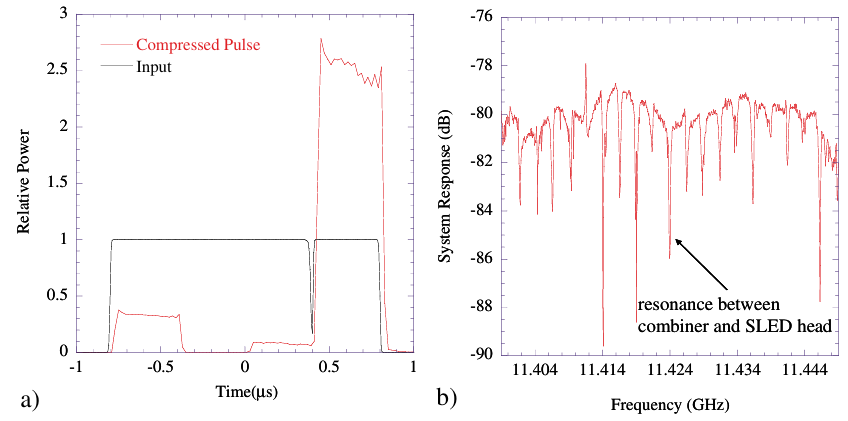
FIG. 20. (Color) Initial overall system response. A spurious resonance occurred at 11.424